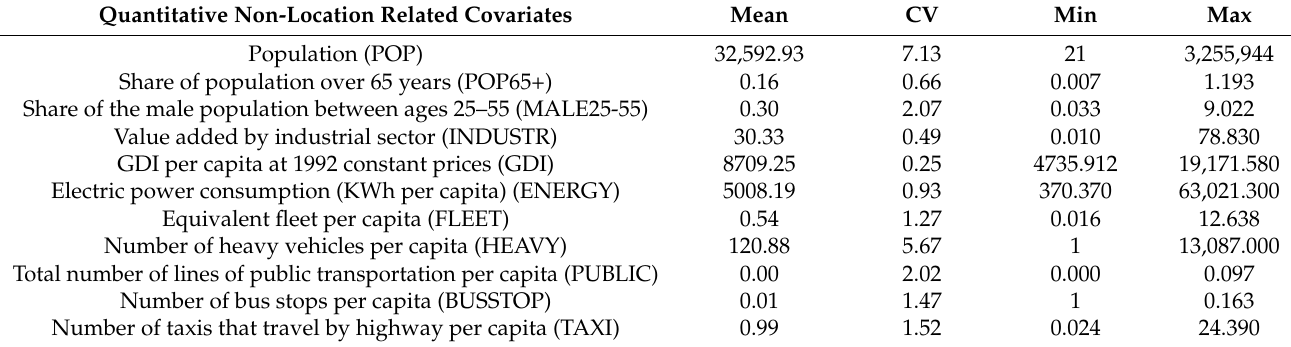
Table 2. Basic summary statistics for quantitative non-location-related covariates ( n = 1790). Quantitative Non-Location Related